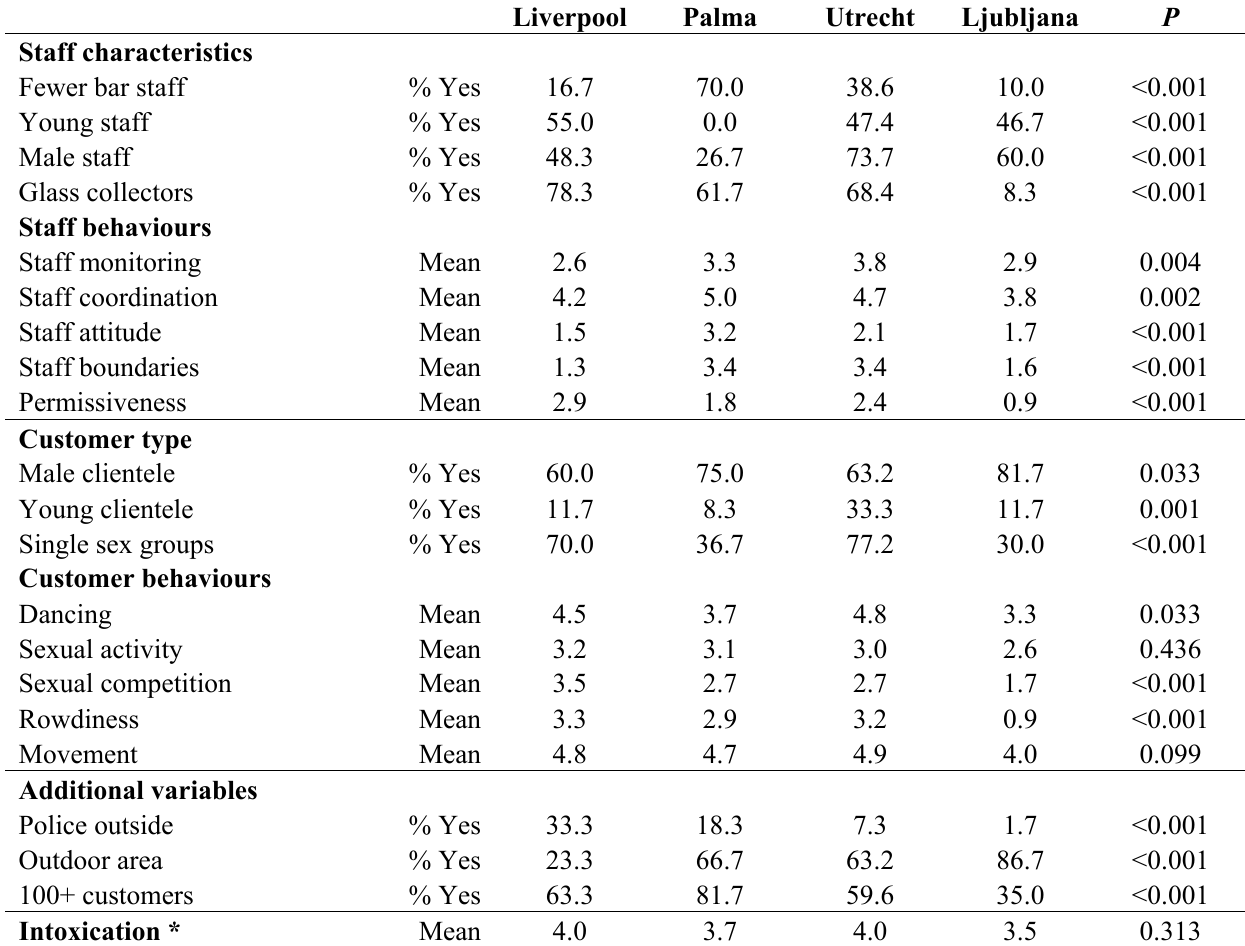
Table 2. Percentage of visits recording staffing and customer factors, and mean ratings for staffing and customer related scales, by